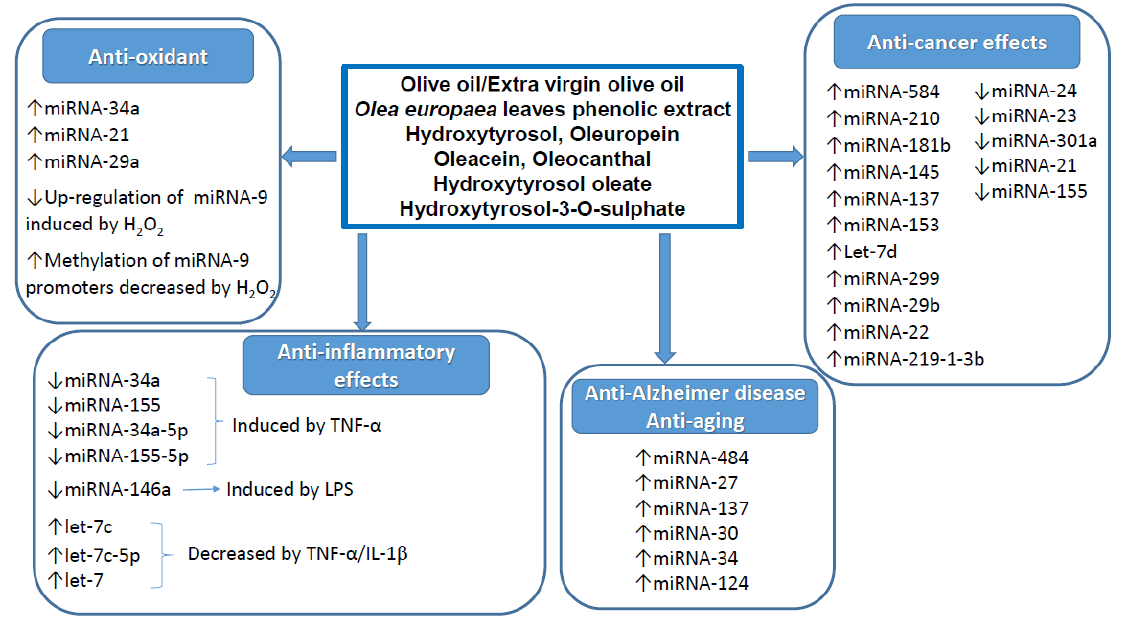
Figure 2. Main effects of olive oil and/or its phenolic compounds on miRNAs expression in relation to different biological and healthy properties. “ ↑ ” and “ ↓ ” indicate increment and decrement of miRNA expression, respectively.